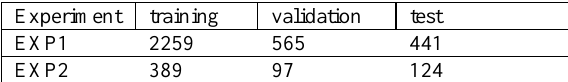
Table 2. Number of image pairs used for each experiment.